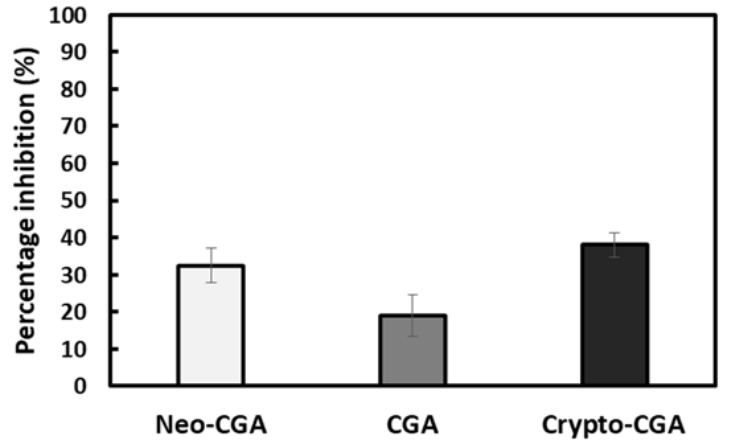
Figure 3. XO inhibitory activities of neochlorogenic acid, chlorogenic acid and crypto-chlorogenic acid. Data are presented as mean ± SEM ( n = 6).